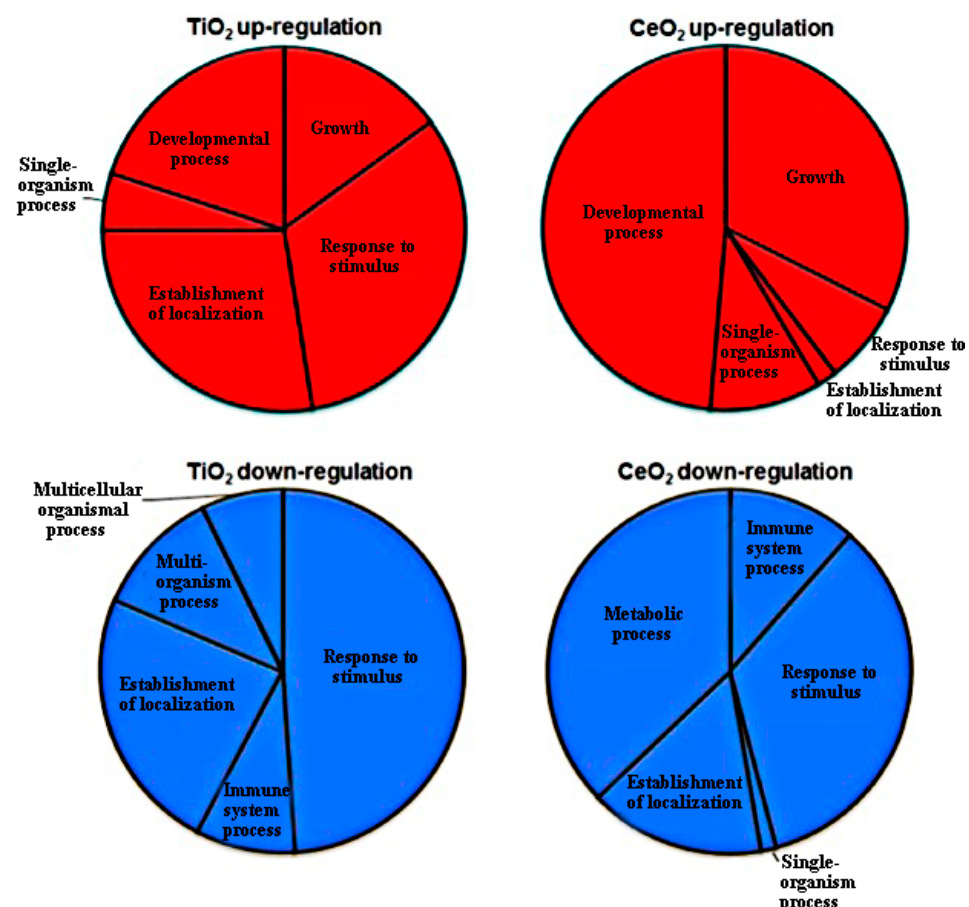
Figure 13. Pie charts of top 5 categories of upregulated and downregulated genes in Arabidopsis thaliana germinants exposed to nano-titania and nano-ceria annotated to broad functions. Reprinted with permission from Ref. [82].